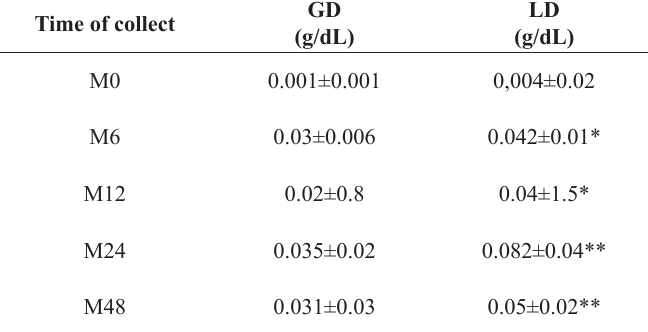
TABLE 2 - Concentration of hemoglobin (g/dL) from